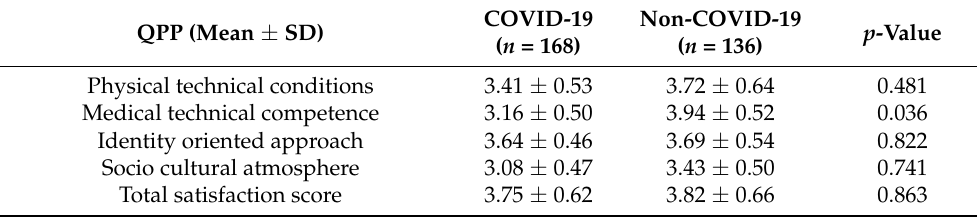
Figure 4. CORE-OM questionnaire results between COVID-19 positive and negative pregnant women.